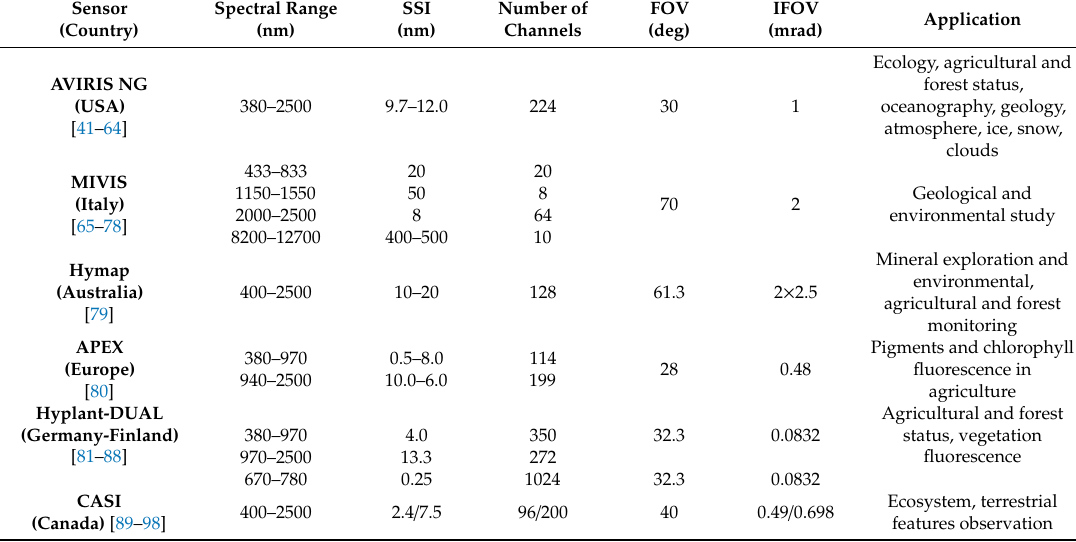
Table 1. Main features of some typical airborne hyperspectral imaging systems, including spectral range, spectral sampling interval (SSI), number of channels, field of view (FOV) and instantaneous field of view